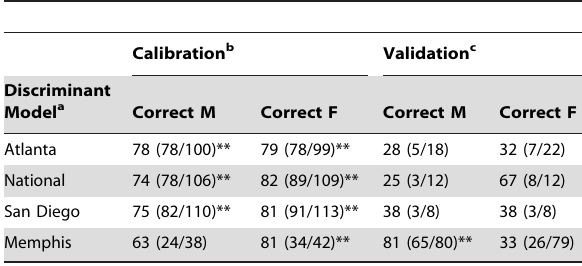
Table 3. Effect of zoo on the ability of near infrared spectroscopy of feces to discriminate between adult male and female captive giant pandas ( Ailuropoda melanoleuca